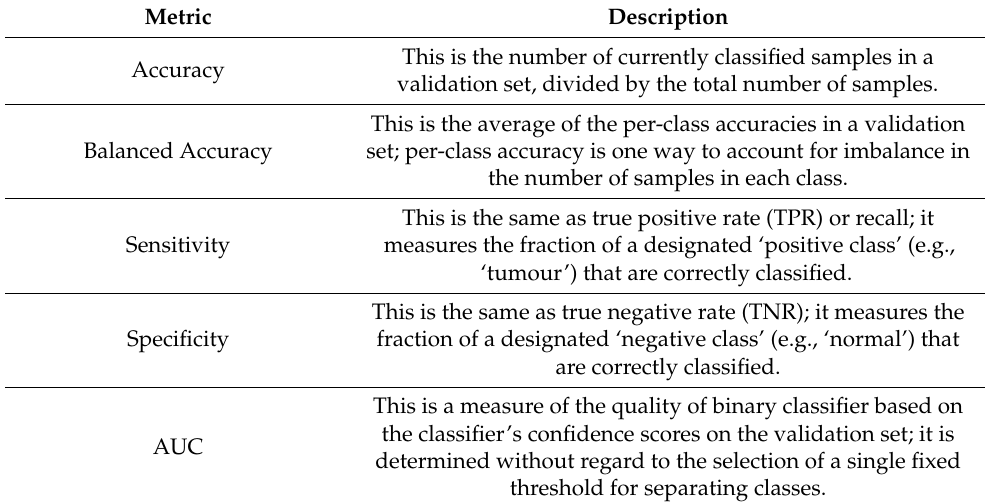
Table 1. Metrics and their